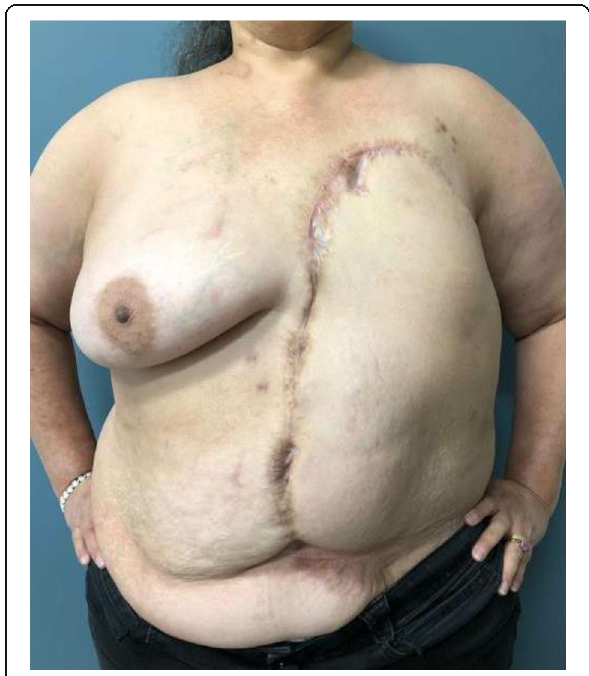
Fig. 2 Postoperative thoracic wall defect status post EOM flap. Image illustrates postoperative results status post re-elevation and mobilization of the left EOM flap required for replacement of the aortic valve. The EOM flap has healed well even with elevation and